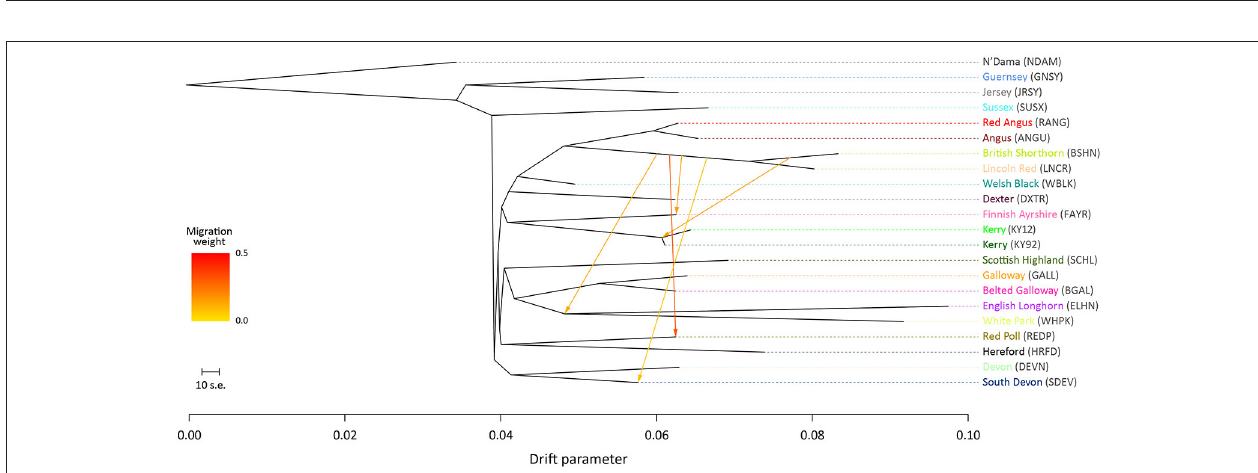
FIGURE 3 | Maximum likelihood (ML) phylogenetic tree network graph with five migration edges ( m = 5) generated for genome-wide SNP data (37,490 autosomal SNPs) from cattle breeds of British and Irish origin (BI data set). The West African taurine N’Dama breed sampled in Guinea is included as a population outgroup. Coloured lines and arrows show migration edges that model gene flow between lineages with different migration weights represented by the colour gradient.